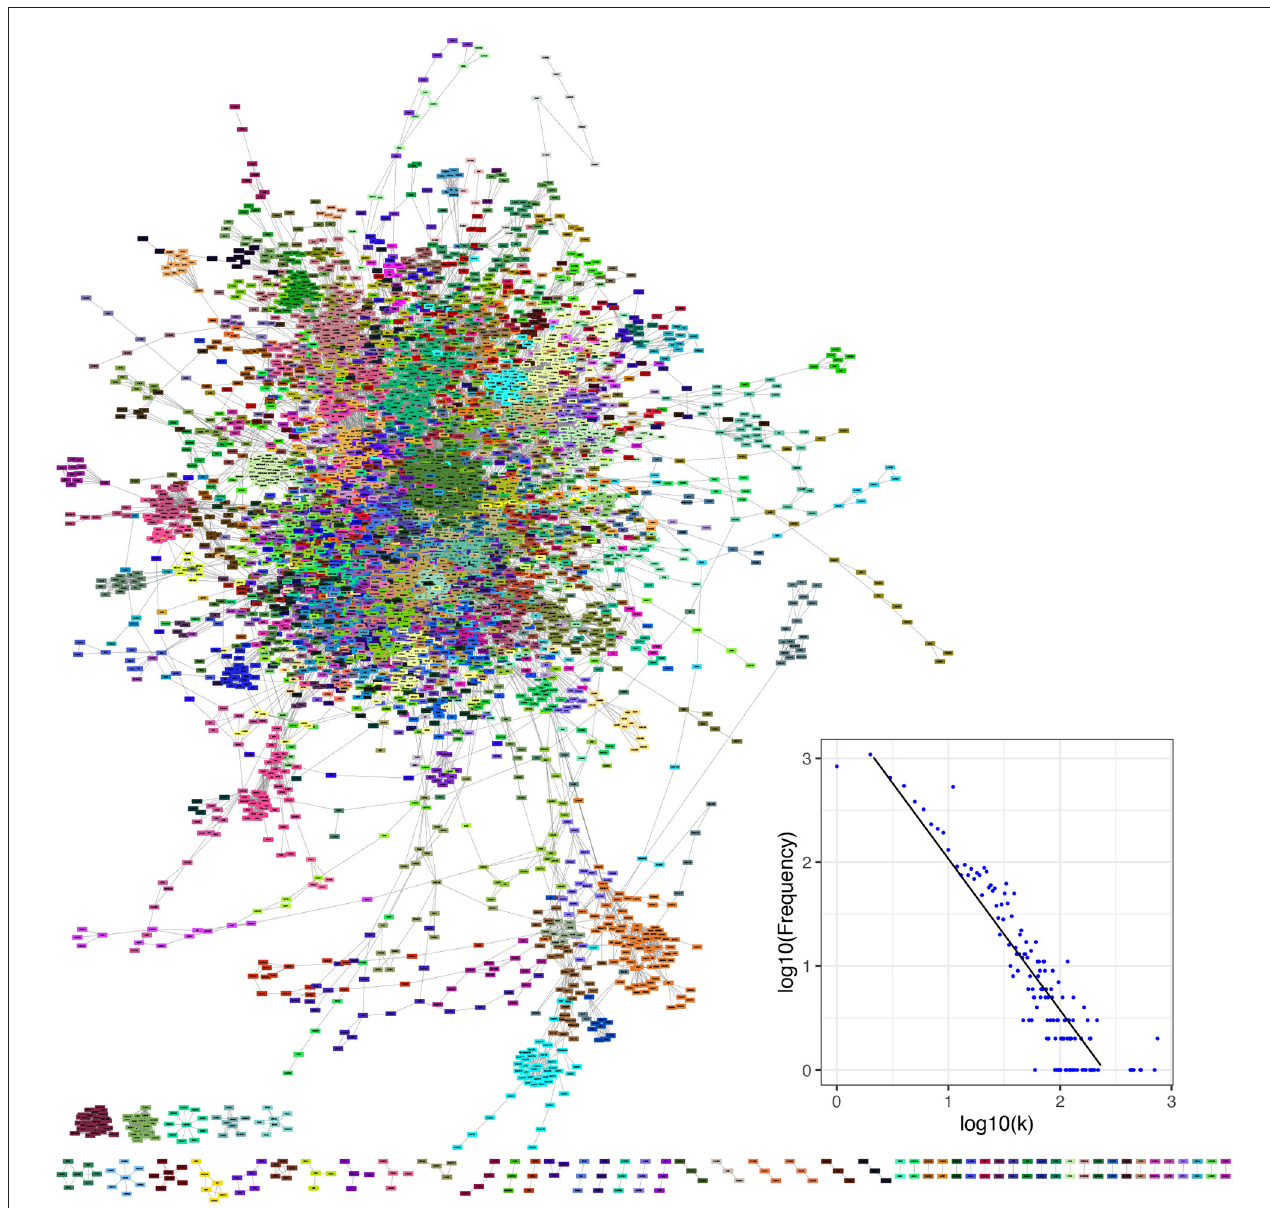
FIGURE 4 | The human metabolism molecular interaction network the whole set of molecular interactions reported in the KEGG database for humans. It consists of 7,123 non-isolated biomolecules and 49,378 interactions (of diverse types) among them. Network communities are depicted by nodes of the same color. The inset shows the degree distribution in log-log scale for KEGG metabolism